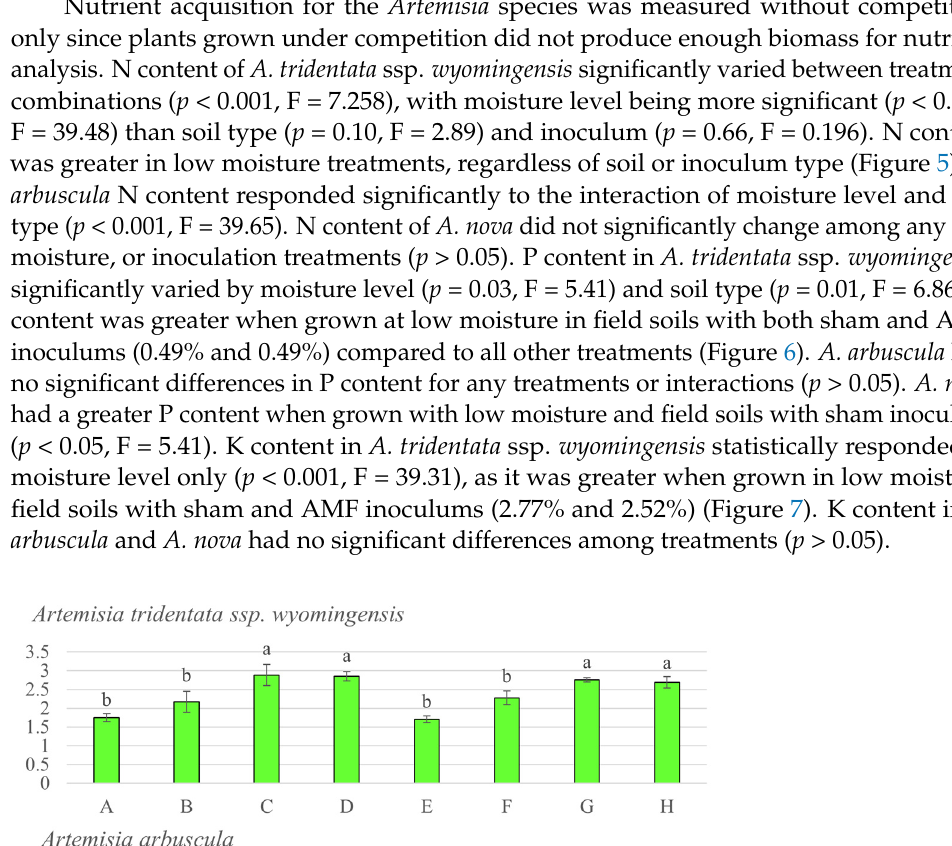
Figure 6. Phosphorus (P) concentration ±SE (error bars) in Artemisia tridentata ssp. wyomingensis , Artemisia arbuscula, and Artemisia nova and their associated Taeniatherum caput-medusae grown as competition . Different letters above bars indicate significant differences among treatments (Tukey’s HSD). P content of Artemisia species grown under competition not measured.